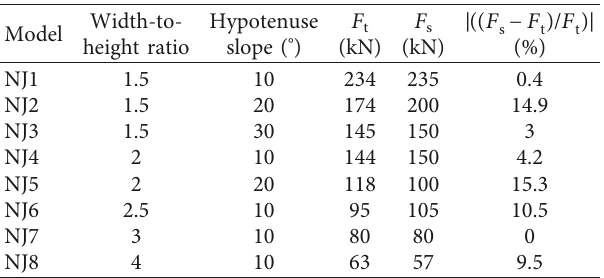
Figure 12: Comparison of the load-deformation curve between numerical result and experimental result for the typical model. (a) NJ1. (b) NJ8. Table 6: Comparison of the uplift bearing capacities between the tested and the simulated